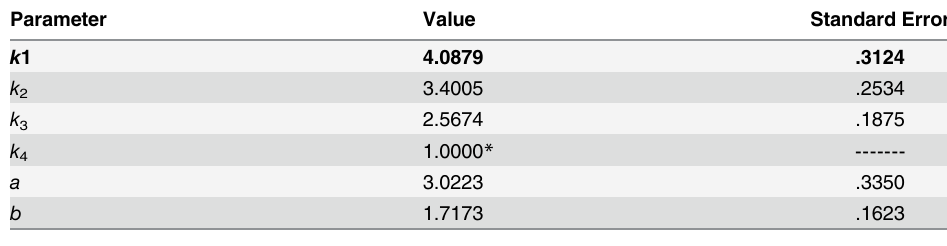
Table 2. Results of Fit to Army